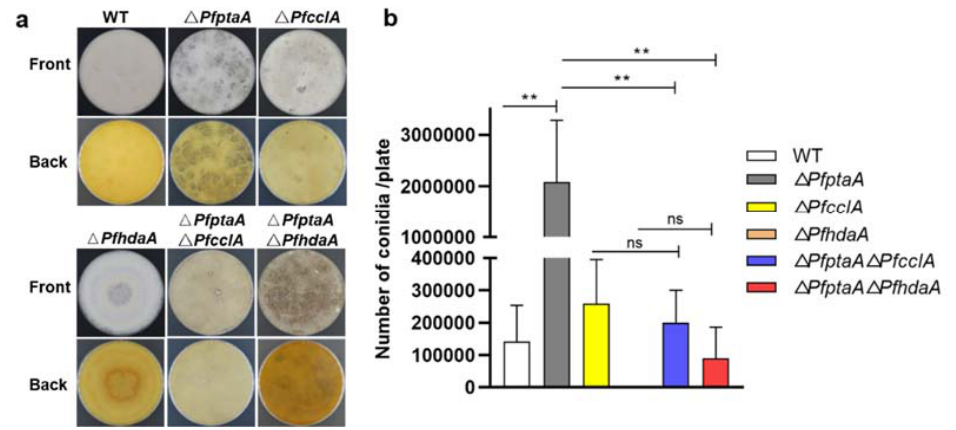
Figure 4. Phenotypic effect on conidia development in P. fici strains. ( a ) Phenotype observations of strains of P. fici WT, Δ PfptaA , Δ PfcclA , Δ PfhdaA , Δ PfptaA Δ PfcclA , and Δ PfptaA Δ PfhdaA ; ( b ) the difference of conidia production in strains of P. fici WT, Δ PfptaA , Δ PfcclA , Δ PfhdaA , Δ PfptaA Δ PfcclA , and Δ PfptaA Δ PfhdaA . All of the strains were grown on PDA plates for number determination at 25 °C for 14 days. Three replicates were done for each culture of strain. Error bars represent the standard deviations. Asterisks indicated significant differences in mean values ( p < 0.01(**); p > 0.05 (ns)).